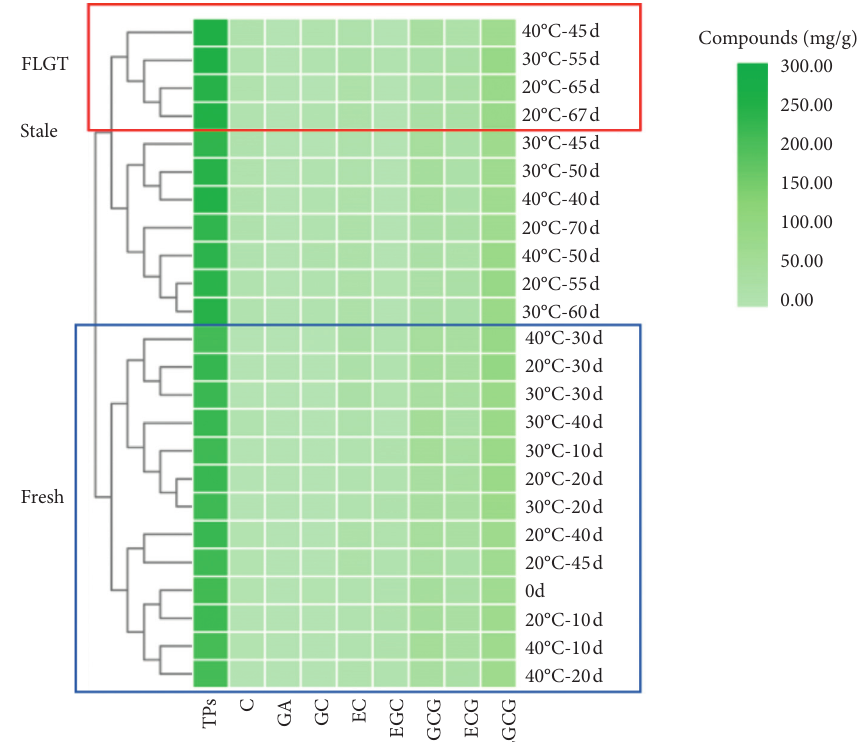
Figure 2: Hierarchical cluster analysis (HCA) for tea samples under the ASLT (20 ° C, 30 ° C, and 40 ° C). Table 5: Sensory evaluation and acceptability test of FLGT stored at 4 ° C for 93 days and at − 20 ° C for 150 days. Store temperature ( ° C) Time